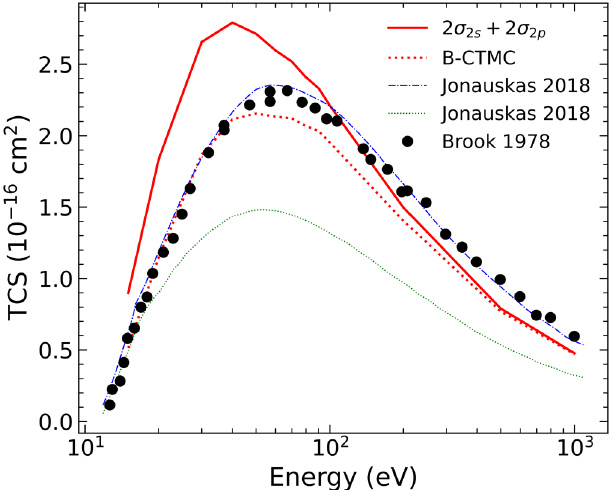
Figure 4. Ionization cross-section as a function of incident energy. Expt.: filled dots: Brook (Ref. [3]). Theories: dash-dotted-blue-line: DWBA in the potential of the ionizing ion (Ref. [18]), dotted-green- line: DWBA in the potential of the ionized ion (Ref. [18]), solid-red-line: present CTMC results using the standard addition rule, dotted-red-line: B-CTMC.